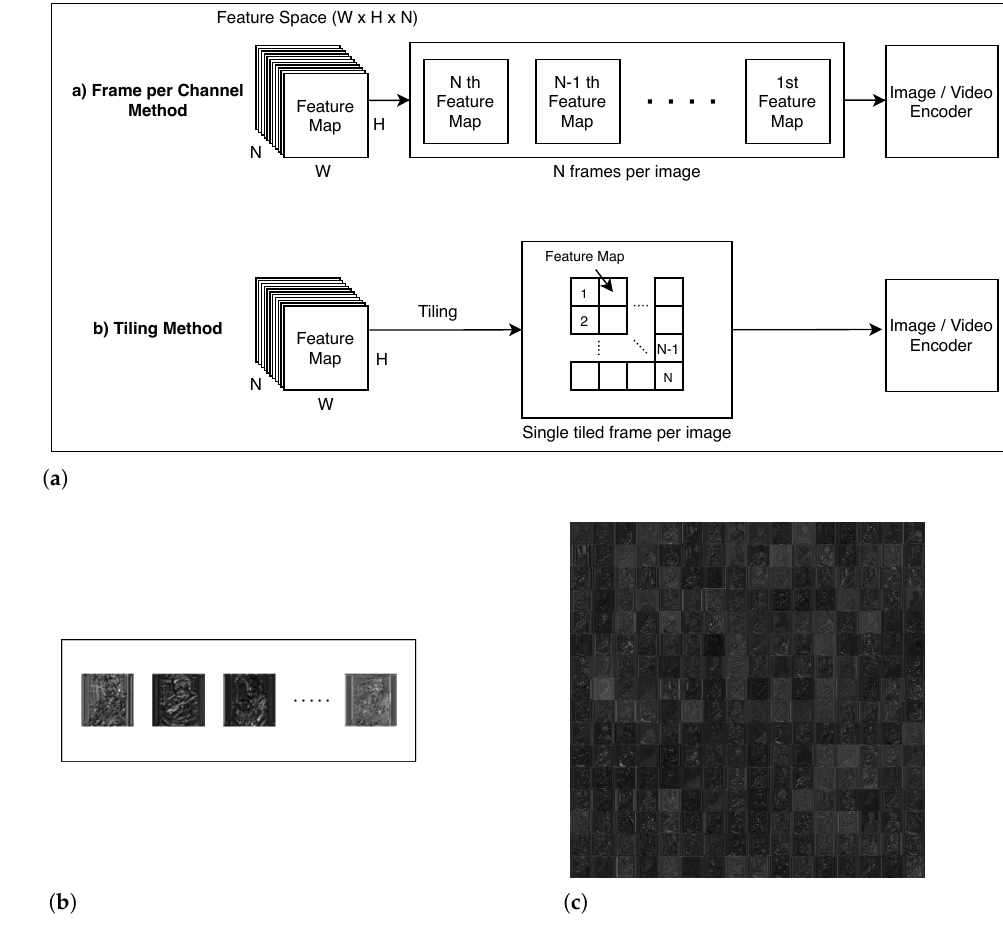
Figure 2. ( a ) Frame per Channel (FPC) and Tiling process, ( b ) visualization of Frame per Channel method, and ( c ) visualization of a tiled feature map.